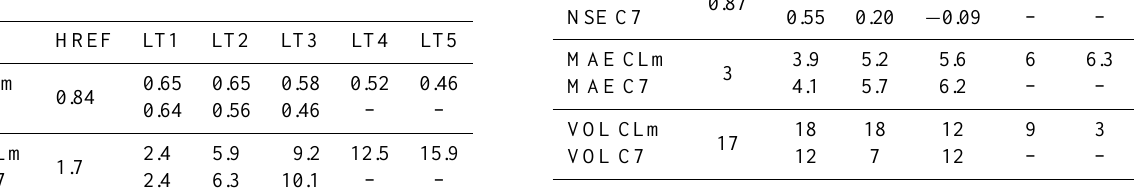
Table 2. Nash Sutcliffe efficiency NSE ( − ) and mean absolute error MAE (cm) for the daily maximum of the Lake Sihl level. HREF re- flects the skill of the hydrological/hydraulic part of the model chain. Forecasts based on COSMO-LEPS median (CLm) and COSMO-7 (C7) are evaluated for lead times (LT) of 1 to 5, and 1 to 3 days, respectively.